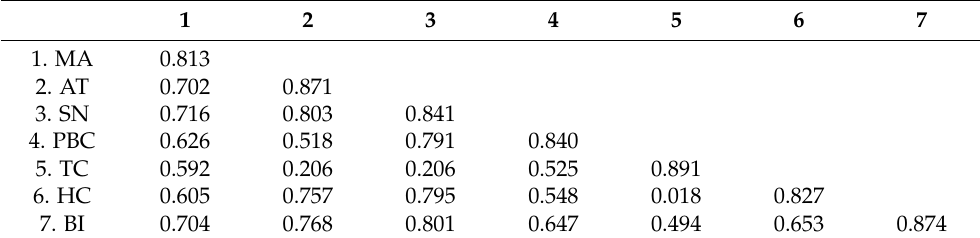
Table 2. Correlation coefficient and AVE square root of measurement model.